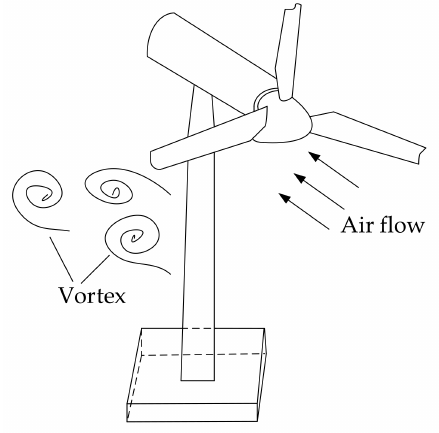
Figure 1. The mechanism of VIV